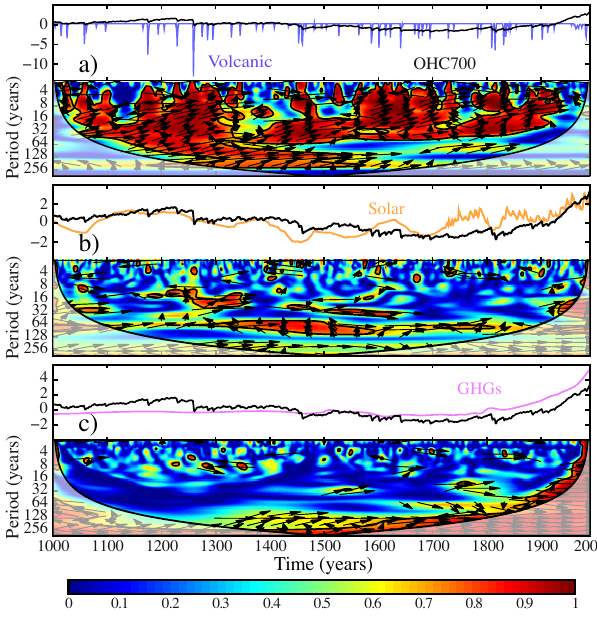
Fig. 10. The same as in Fig. 9 but for OHC700 and the standardised series of (a) volcanic forcing, (b) solar irradiance, and (c) effective GHG